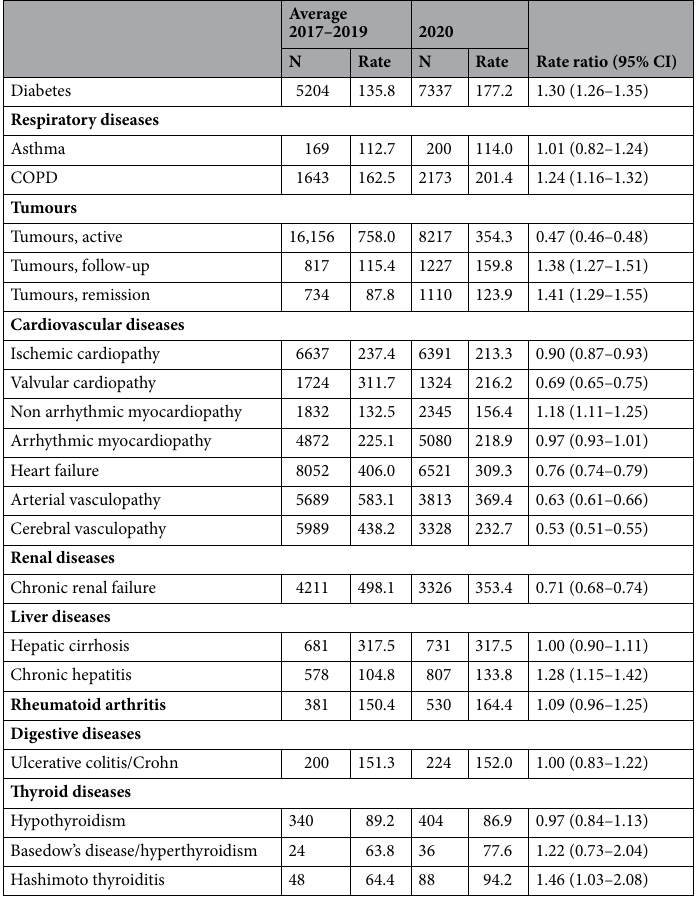
Table 3. Number of hospitalizations and corresponding rate (per 1000) among individuals aged 65 years or more with a chronic disease from ATS Brianza and ATS Bergamo by major chronic diseases in 2017–2019 and 2020, and rate ratio between the two periods. Lombardy,